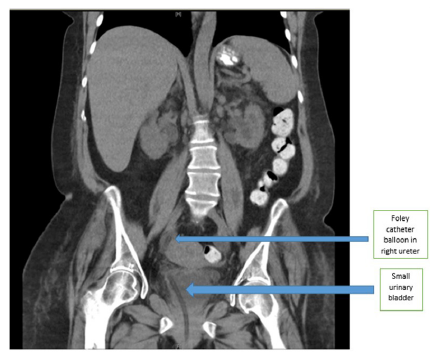
Figure 2. CT scan of the abdomen showing small urinary bladder capacity and transurethral Foley catheter balloon in the distal right ureter.